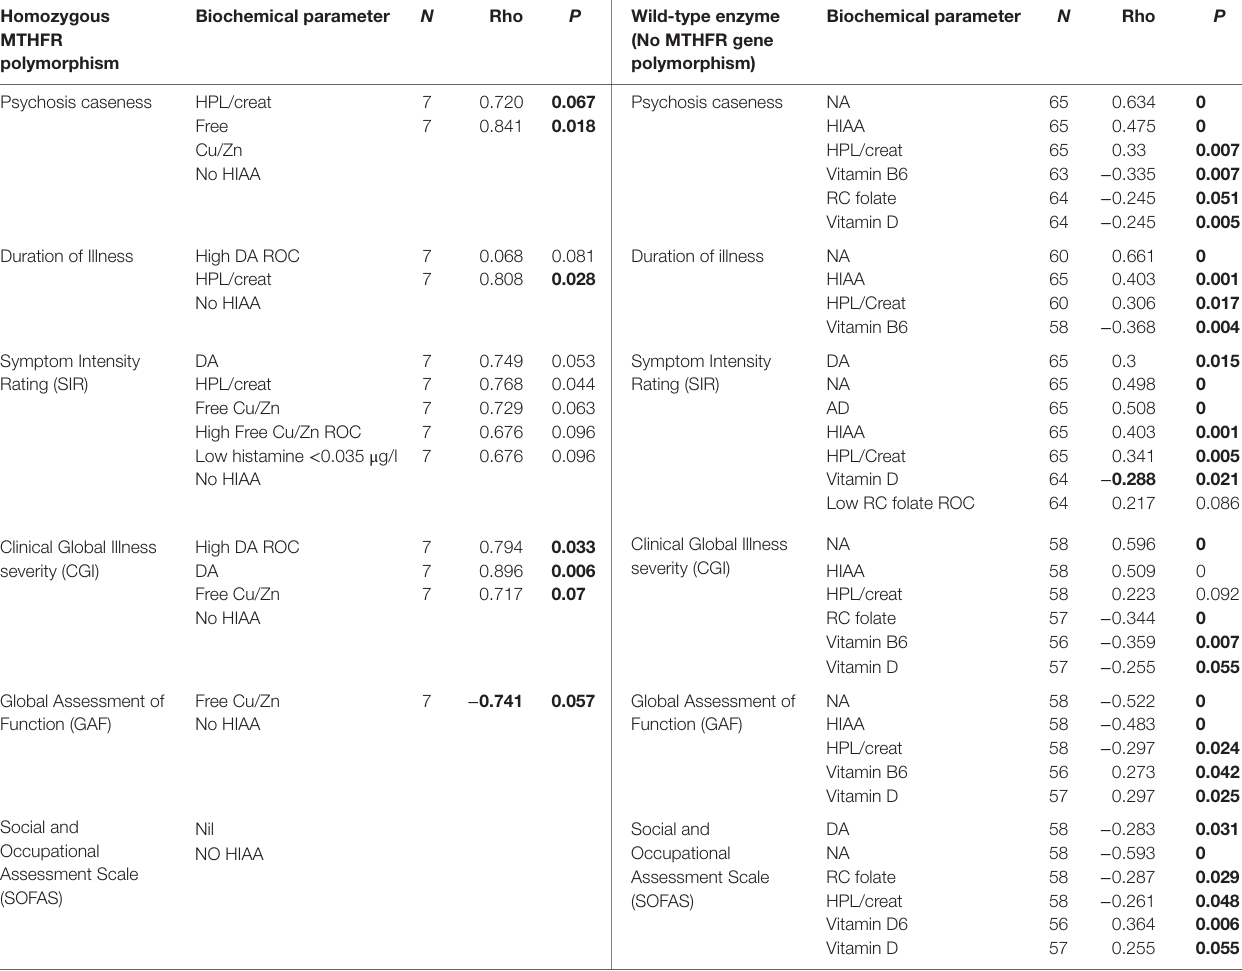
TaBle 7 | MThFr 677 split-sample correlates for psychosis caseness and functional measures, at 95% ci. homozygous